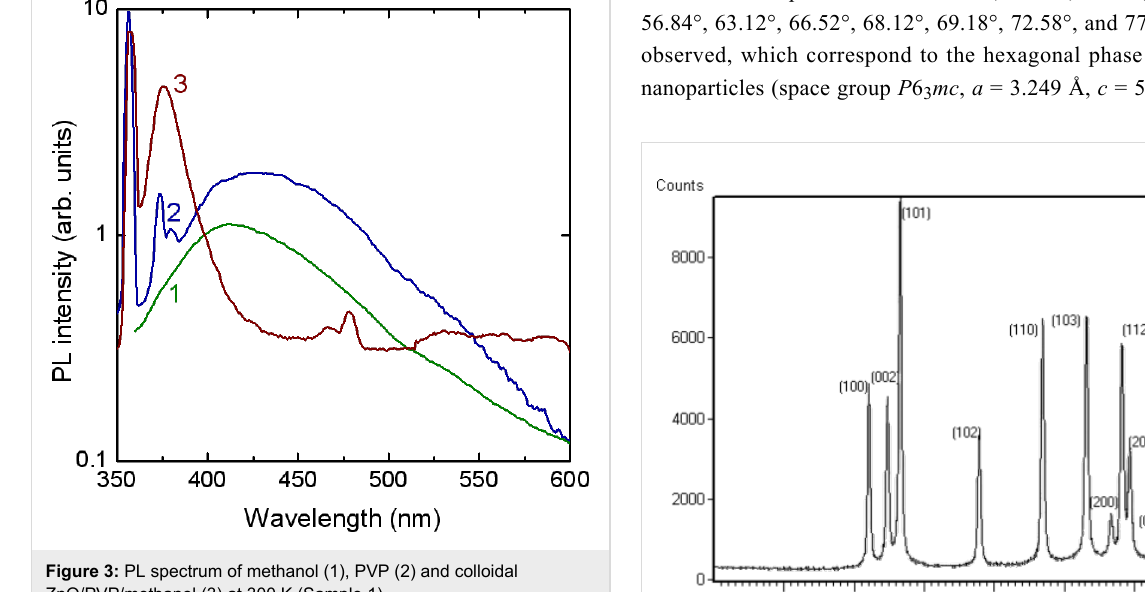
600 nm. Two luminescence bands at 356 nm and 373 nm domi-